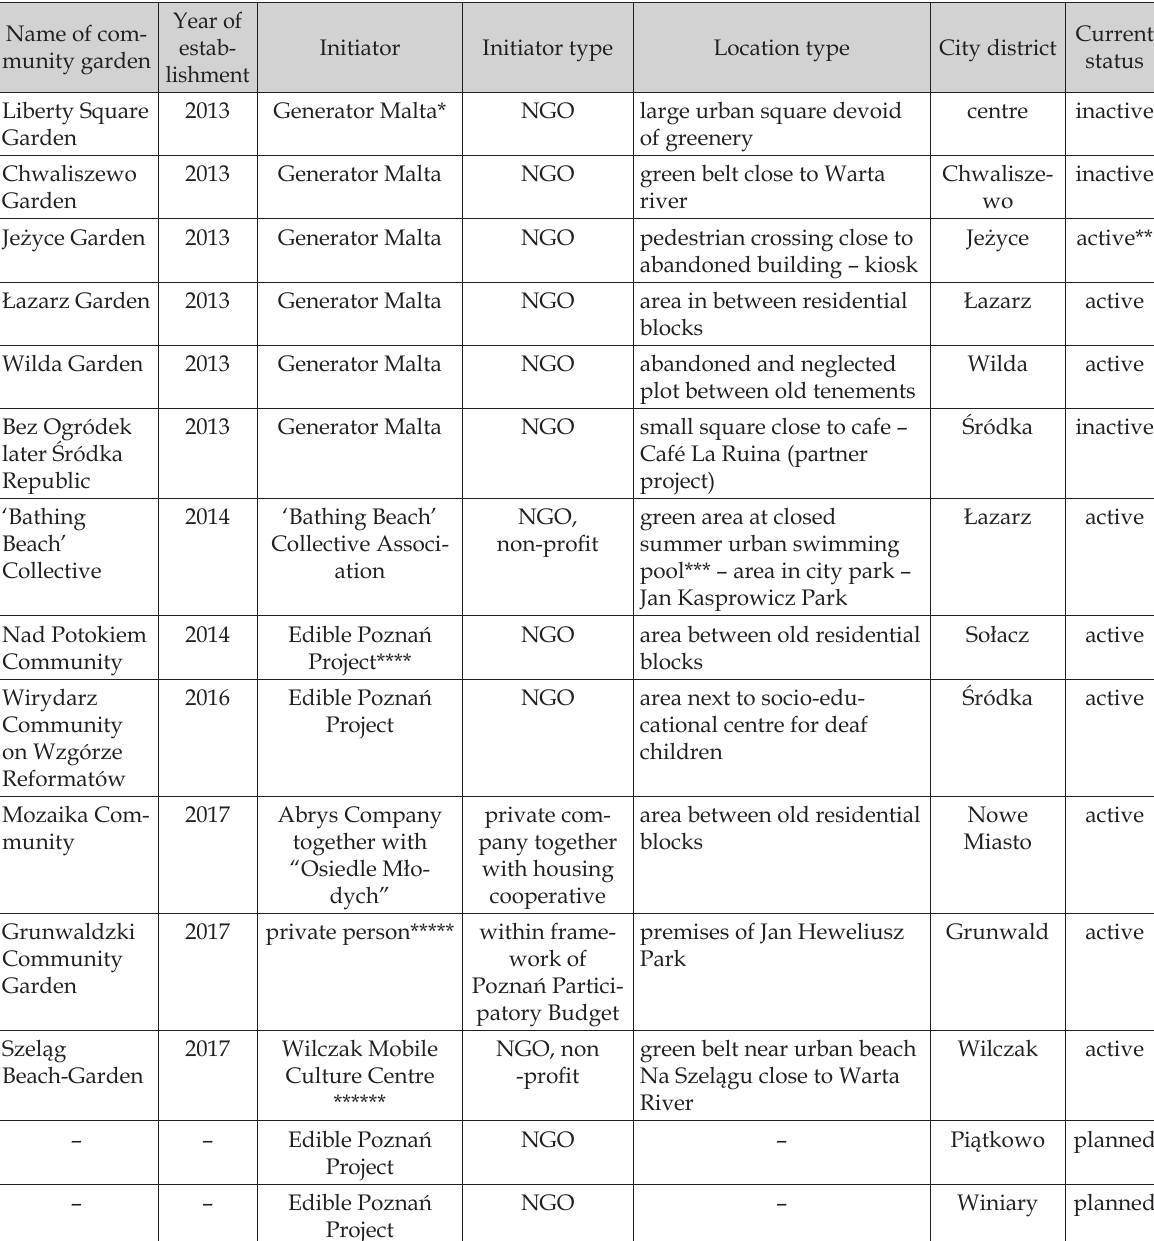
Table 1. Community gardens established and planned in Poznań in